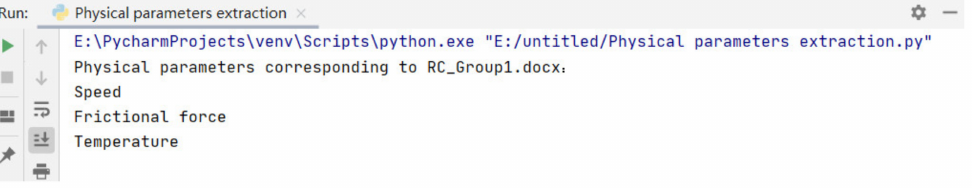
Figure 3. Extracted physical parameters corresponding to root causes with Python. (2) Extraction of engineering parameters.